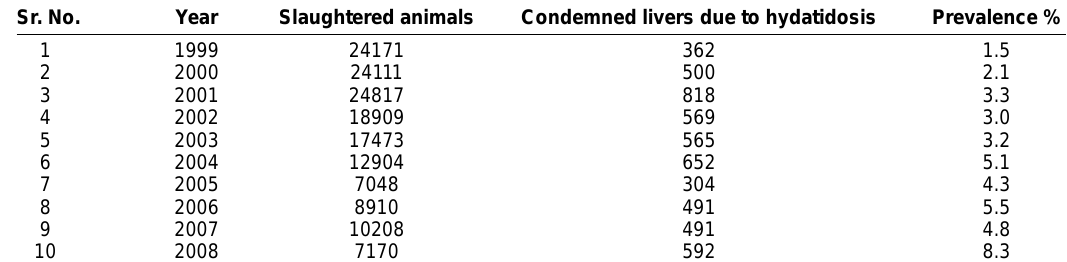
Table-1: Number of slaughtered animals, condemned number of livers, and the annual prevalence of Hydatidosis at Keren Slaughterhouse (1999-2008). Sr.